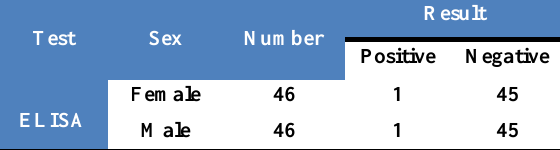
Table, 3: The positive and negative results of Toxoplasmosis in sheep (female and male) by using ELISA test